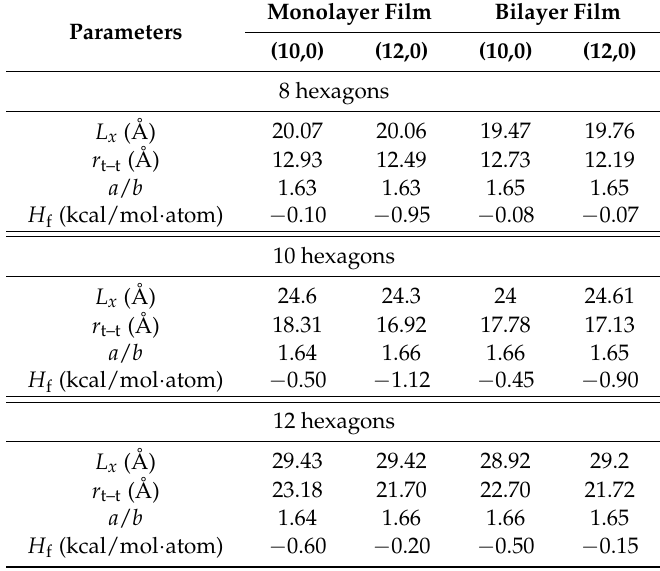
Figure 1. Super-cells of mono- and bilayer graphene–carbon nanotube (CNT) composite films with CNT (12,0) and an inter-tube distance of 12 hexagons. Table 1. Geometric and energy parameters of mono- and bilayer graphene–carbon nanotube (CNT) composite films.